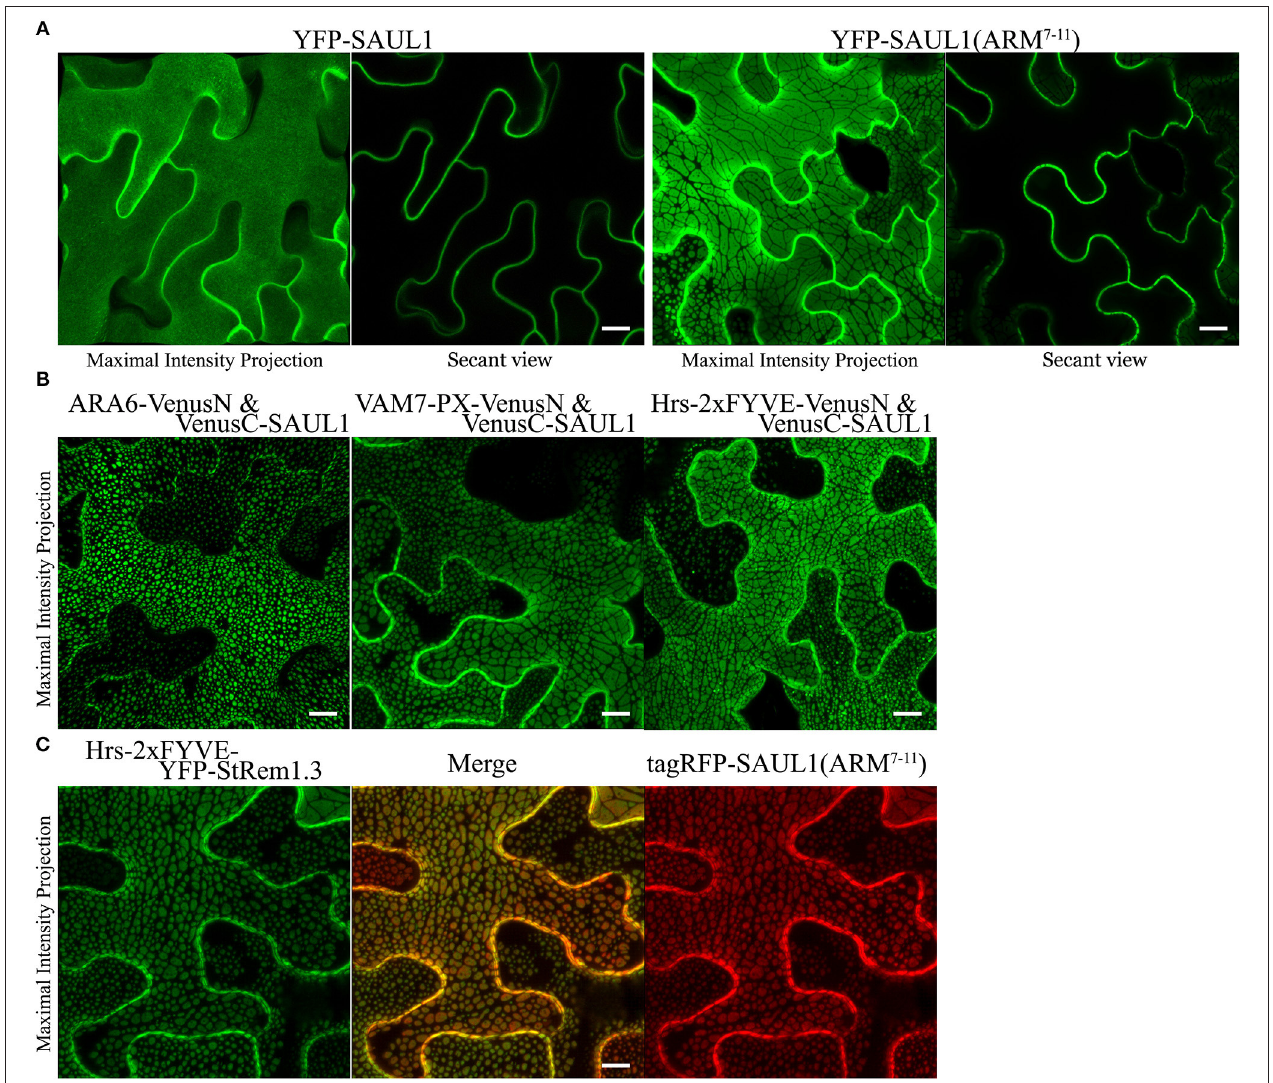
FIGURE 6 | Association of membrane patches with E3 ubiquitin ligase SAUL1 in N. benthamiana leaf cortical cells. (A) Subcellular localization of YFP-tagged full-length SAUL1 and YFP-tagged SAUL1 C-terminal ARM repeats 7-11. (B) The full-length SAUL1 co-expressed with either ARA6, or VAM7-PX, or Hrs-2xFYVE in BiFC complexes forms patches indicative of PM-MVB/TP tethering. (C) Co-localization of membrane patches created by expression of Hrs-2xFYVE-YFP-StRem1.3 and patches created by expression of tagRFP-SAUL1(ARM 7 − 11 ). All scale bars are representing 10 µ